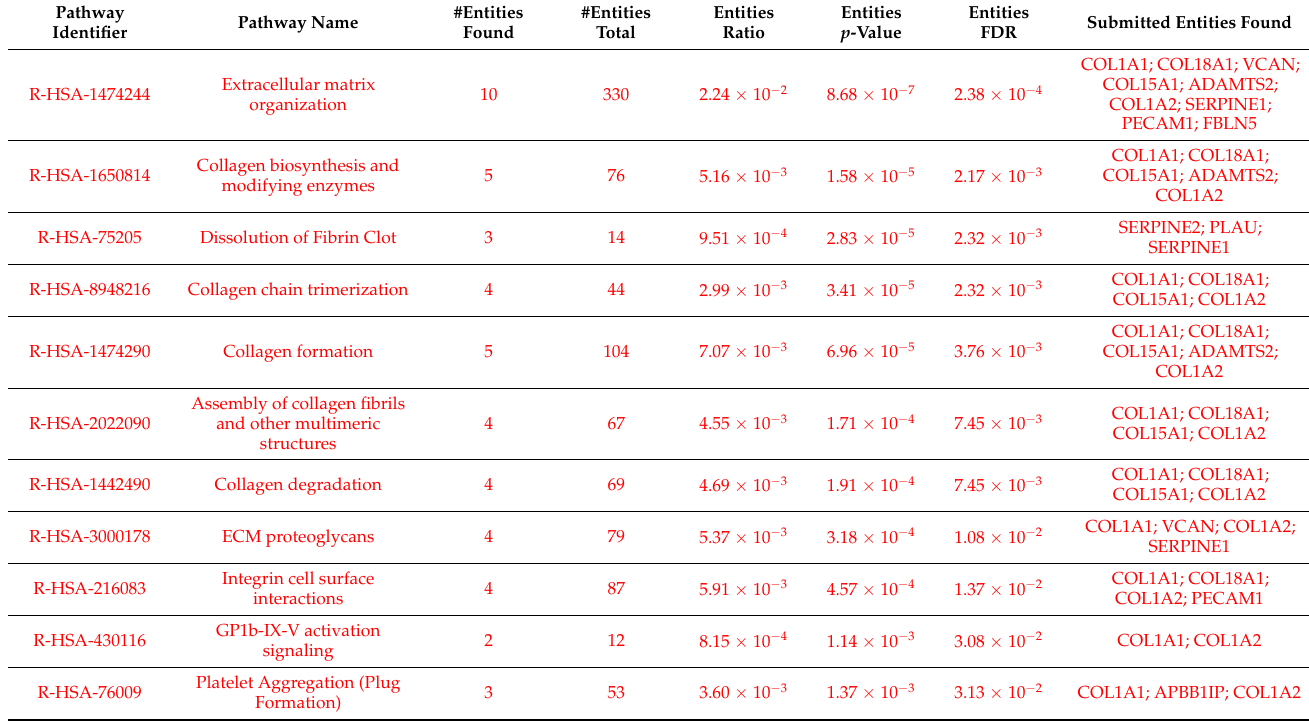
Table 5. The top 15 pathways enriched from the DEGs that differently altered in response to OA in male and female cartilage. Pathways with an FDR less than 0.05 are highlighted in